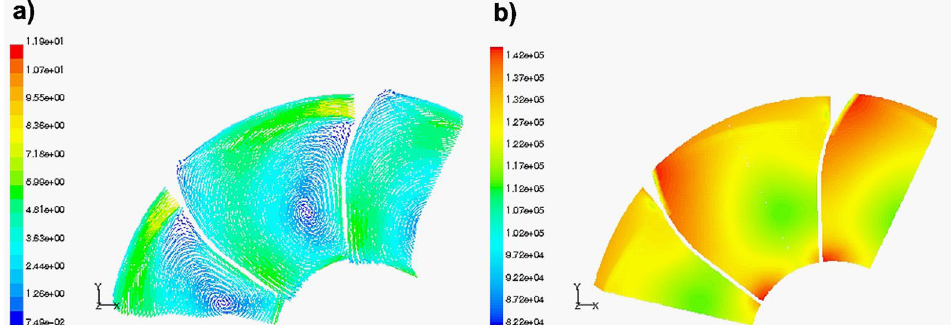
Figure 19. The field of: ( a ) velocity [m/s]; ( b ) static pressure [Pa] in the channels of the guide vanes for the basic variant (stator A4).